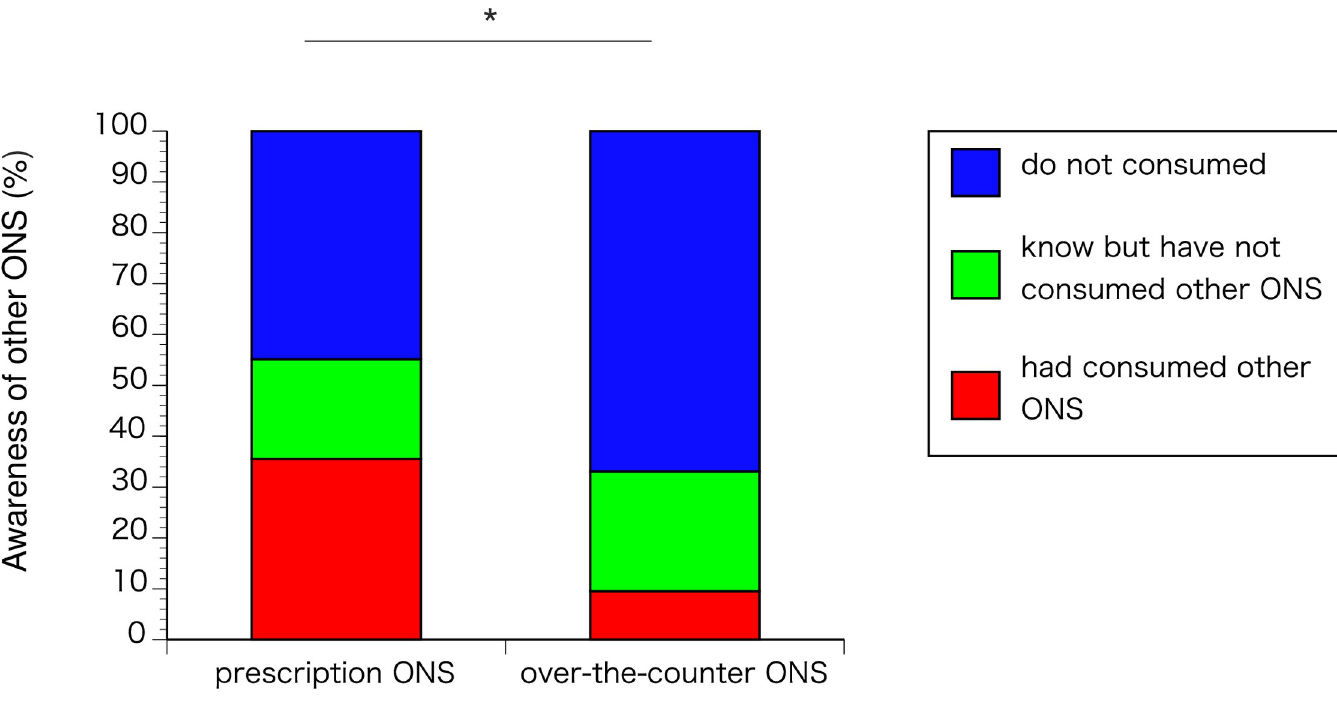
Fig 7. Awareness of other ONS. � p < 0.0001.